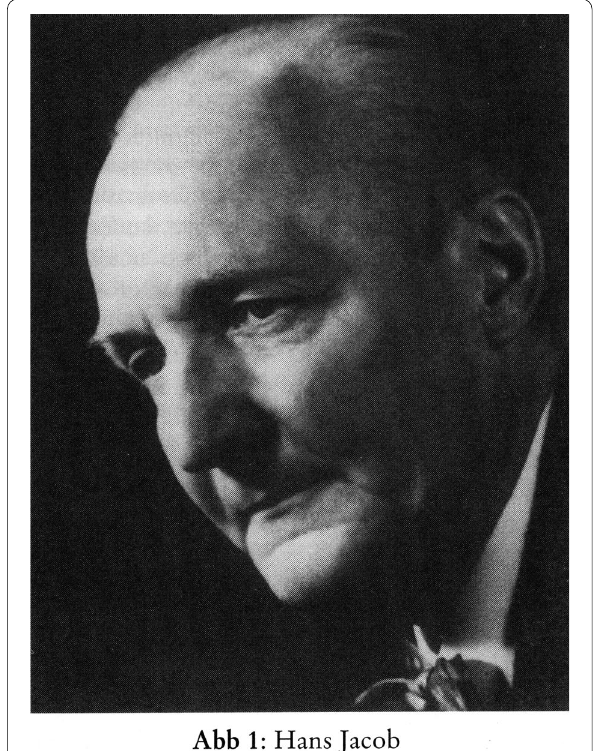
Fig. 1 Hans Jacob. Undated photography, once hanging in the Psychiatric and Neurological Clinic of the University of Marburg. With permission of Professor Hans-Dieter